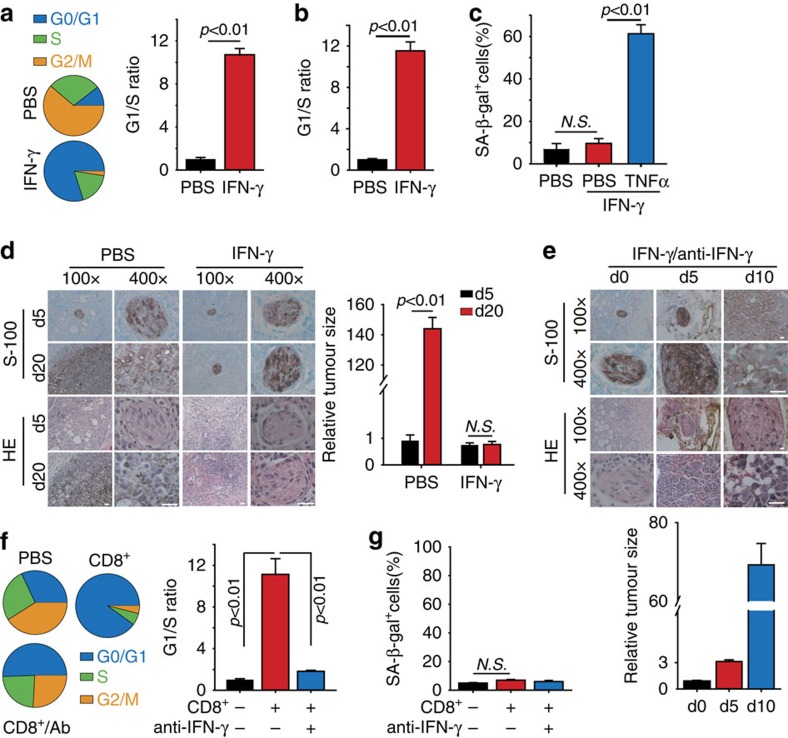
IFN-γ induces TRC dormancy in vivo.(a,b) C57BL/6 mice with 5 × 5 mm B16 melanoma were intratumorally treated with 10 μg IFN-γ once per day for 3 days (n=6 per group). Isolated primary tumour cells were assayed for cell cycle analysis (a). Or CD133high tumour cells were sorted from tumour by FACS and performed cell cycle analysis (b). (c) the same as a, but mice were treated with 10 μg IFN-γ in the presence or absence of TNF-α once per day for 3 days. Isolated primary tumour cells were stained with SA-β gal. (d) B16 TRCs (5 × 103) were subcutaneously injected to mice. On day 3, 10 μg IFN-γ was directly injected into tumour site once every 2 days (n=8 per group). On day 5 and day 20, tumour cell-injected tissues were analysed by immunostaining against S100β or H&E staining. The tumour size was presented photographically (left) and graphically (right). Bar, 25 μm. (e) 5 × 103 B16 TRCs were subcutaneously injected to C57BL/6 mice, and then mice were intratumorally treated with IFN-γ (10 μg per day) for 10 days, and then further treated with IFN-γ or IFN-γ+anti-IFN-γ antibody (250 μg per day) once every two days (n=8 per group). Tissues at the injection site were collected on day 10 (d0), day 15 (d5) or day 20 (d10), and used for immunostaining against S100β or H&E staining. Bar, 25 μm. (f,g) Mice were s.c. injected with 2 × 105 OVA-B16 TRCs (n=8 per group). When the tumour size reached 3 × 3 mm, mice were adoptively transferred with OVA-specific CD8+ T cells (1 × 107 cells per mouse) once per two days for twice. Some mice were pretreated with anti-IFN-γ antibody (250 μg per day) once per two days for twice. The isolated primary tumour cells were performed cell cycle analysis (f) and SA-β gal staining (g). In this figure, the data represented mean±s.e.m., NS, no significant difference (Student's t-test).